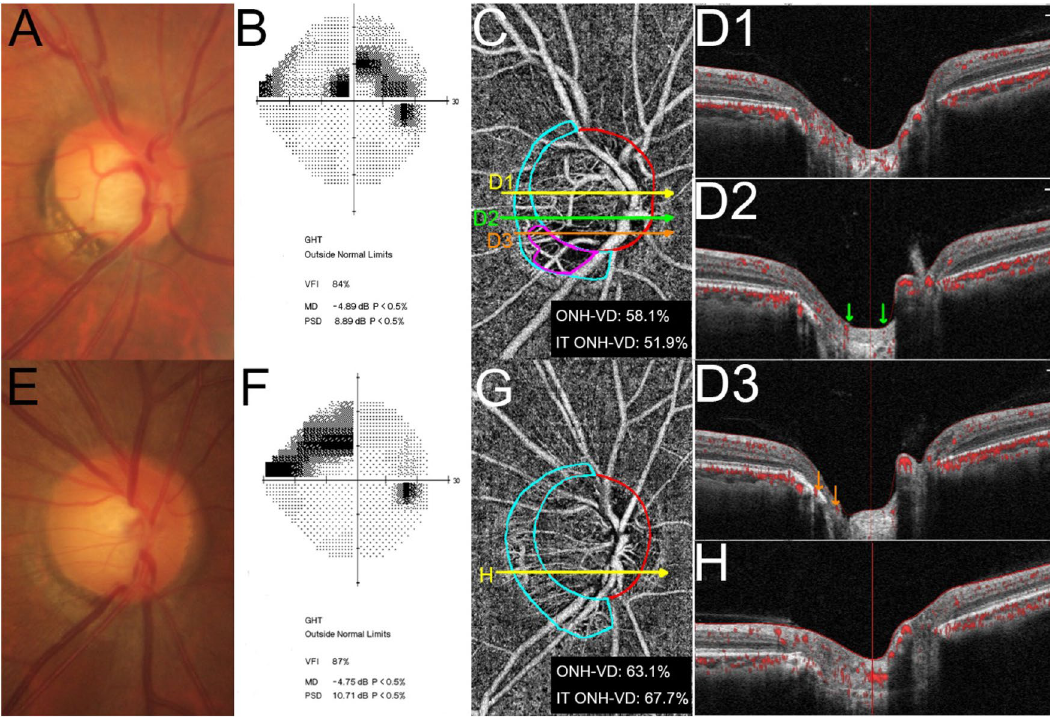
Figure 1. Representative eyes with and without choroidal microvasculature dropout (CMvD) having superior hemifield visual field (VF) loss. ( A – D ) A 53-year-old male with open-angle glaucoma (OAG) and CMvD in his right eye. ( E – H ) A 51-year-old male with OAG without CMvD in his right eye. Both eyes were similar in terms of age, gender, and VF severity. The CMvD(+) eye showed inferotemporal (IT) neural rim thinning ( A ) and superior paracentral VF loss with mean deviation (MD) of − 4.89 dB ( B ). In optical coherence tomography angiography (OCT-A) en-face image of the optic nerve head (ONH), loss of IT ONH vessel density (ONH-VD) adjacent to the CMvD location was observed with IT ONH-VD measured to be 51.9% ( C ). A horizontal B-scan revealed an intact microvasculature signal in the prelaminar tissue and anterior portion of lamina cribrosa (LC) where there was no ONH-VD loss ( D1 ). In contrast, another horizontal B-scan showed loss of microvasculature signal in the prelaminar tissue and anterior portion of LC in the area between the 2 green arrows where there was ONH-VD loss ( D2 ). Another horizontal B-scan showed that the loss of a microvasculature signal was also observed in the choroidal layer between the 2 orange arrows where there was a CMvD next to the presence of ONH-VD loss ( D3 ). The red ellipse and sky blue lines indicate the ONH and β-zone parapapillary atrophy margin. The CMvD area is enclosed by the purple colored border. The CMvD(−) eye also showed IT neural rim thinning ( E ) and superior peripheral VF loss with MD of − 4.75 dB ( F ). In OCT-A en-face image of the ONH, an intact ONH-VD was observed in the IT ONH location with IT ONH-VD measured to be 67.7% ( G ) and intact microvasculature signal in the prelaminar tissue and anterior portion of the LC ( H ). All OCT-A images were created by Avanti system version